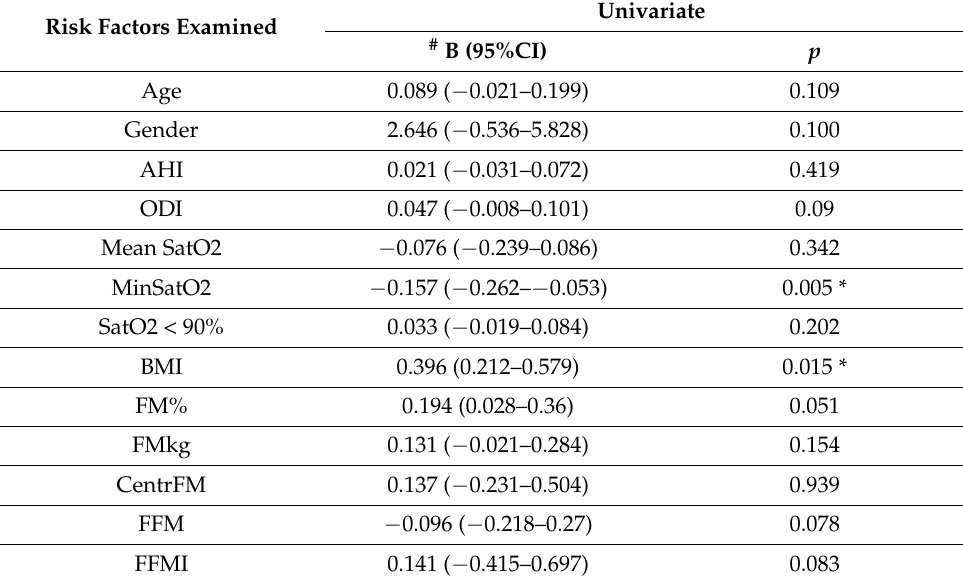
Figure 4. Correlation of serum interleukin-6 (IL-6) and saturation (SatO2) < 90% ( r = 0.437, p = 0.033) .